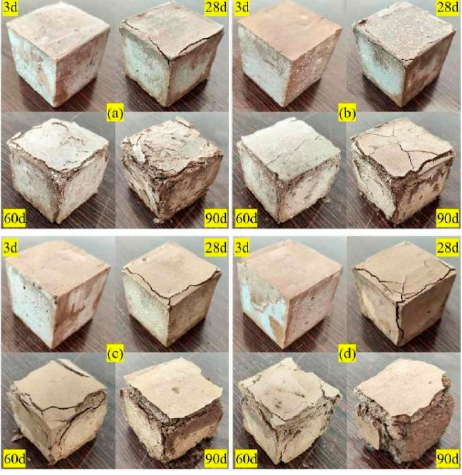
Figure 3. Visual appearance of SF-GSSS immersed in a MgSO 4 solution: ( a ) S10F0; ( b ) S9F1; ( c ) S8F2; and ( d ) S7F3.